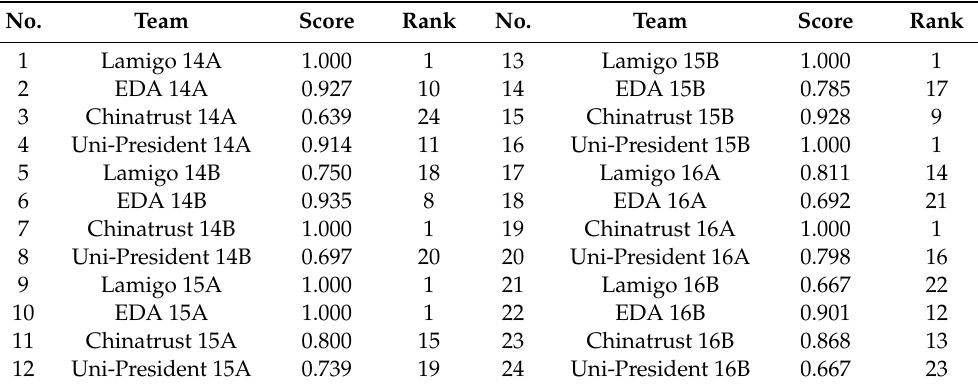
Table 5. Integration e ffi ciencies and ranking of CPBL